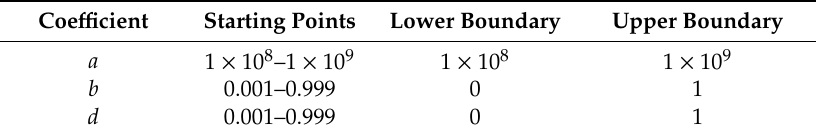
Table 1. List of initial points, upper and lower boundary.